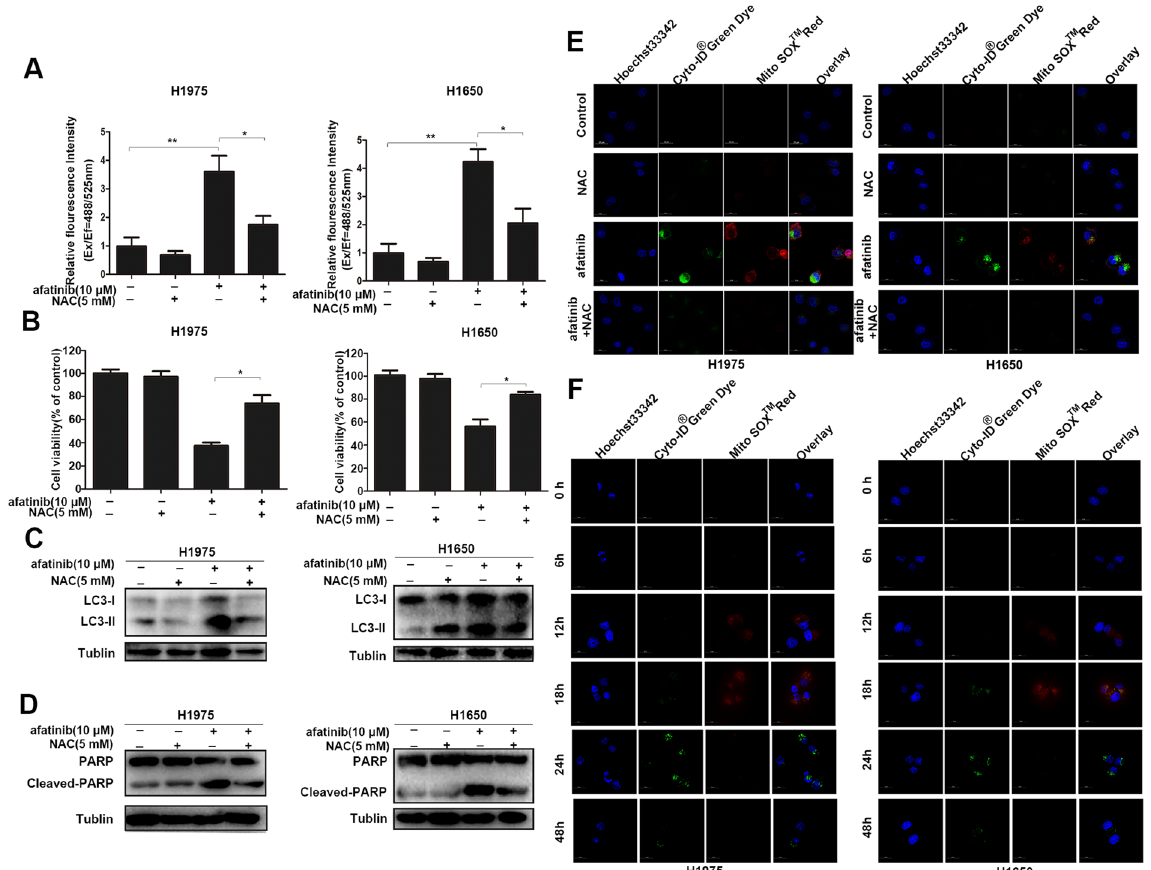
Figure 7. The autophagy and cytotoxicity induced by afatinib are related to intracellular ROS. ( A – E ) H1975 and H1650 cells were treated by 10 μ M afatinib in the presence or absence of 5 mM NAC for 48 h. ( A ) ROS assay kit was used to analyze intracellular ROS by measuring the DCF fluorescence intensity ( * P < 0.05, ** P < 0.01). ( B ) Cell viability was analyzed with MTT assay ( * P < 0.05). ( C ) The levels of LC3-I/II were measured by western blot analysis. These blots were cropped with Photoshop CS6. ( D ) Western blot analysis was used to detect the level of PARP and Cleaved-PARP. These blots were cropped with Photoshop CS6. ( E ) H1975 and H1650 cells were co-stained with Cyto-ID ® Green Dye and Mito Sox TM Red Dye at 37 °C for 15 min, and detected by confocal microscopy. ( F ) After treated with 10 μ M afatinib for 0, 6, 12, 18, 24 and 48 h, H1975 and H1650 cells were stained with Cyto-ID ® Green Dye and Mito Sox TM Red Dye at 37 °C for 15 min, then analyzed by confocal